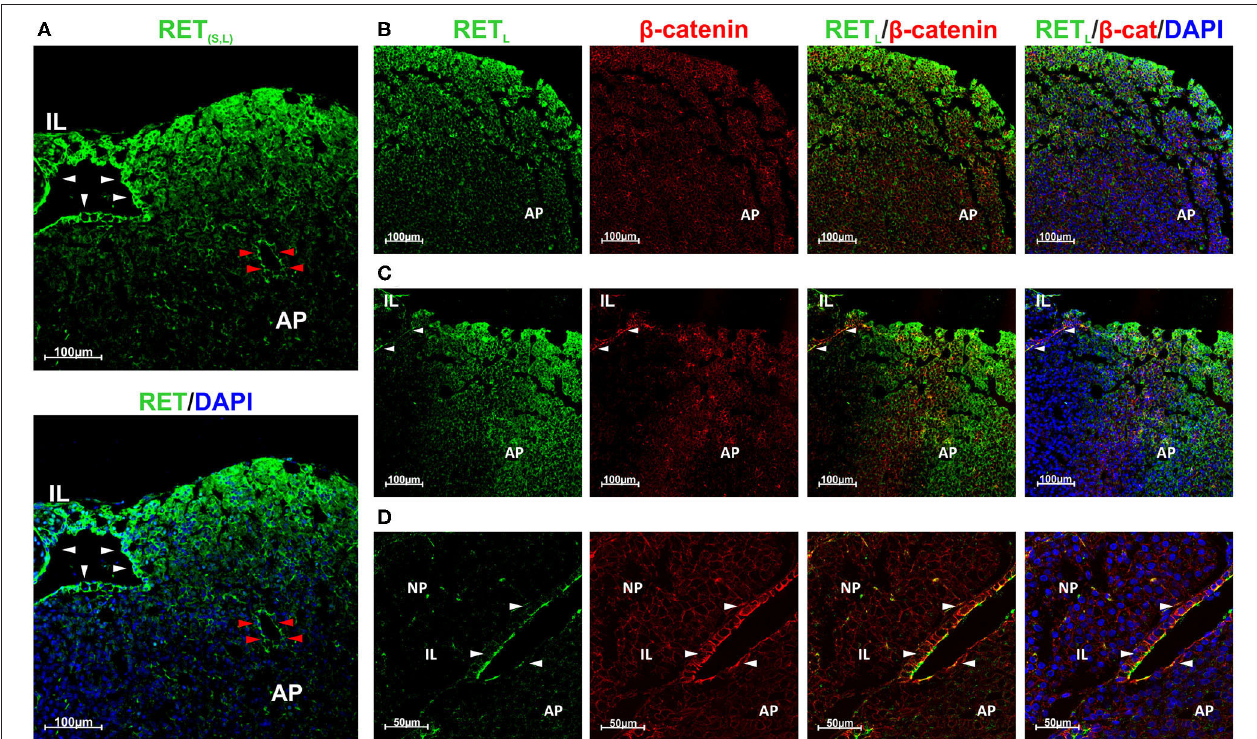
FIGURE 2 | GPS cells at the pituitary stem cell niche co-express RET and β -catenin. RET is also expressed by endocrine cells at the periphery of the AP lobes. (A) High RET expression (green) in the stem cell niche (white arrowheads) and in one follicle within the AP (red arrowheads). It was detected with an antibody recognizing both isoforms (S and L). RET is also expressed at the periphery of the AP lobe. (B–D) : RET was detected with an antibody for RET L isoform. (B) At the AP, RET (green) is expressed at the periphery of the lobe and do not colocalize with β -catenin ( β -cat, red). DAPI (blue) is used to reveal the nuclei. (C) At the marginal zone between the IL and the AP the GPS cells reside, forming the pituitary niche. RET (green) and β -catenin (red) are co-expressed in GPS showing yellow blended color (arrowheads). In the AP, RET does not colocalize with β -catenin. (D) Higher magnification at the niche, shows colocalization of RET (green) and β -catenin (red) at the GPS cells (yellow at the combined projection, indicated by arrowheads). AP, Adenopituitary; IL, Intermediate Lobe; NP,